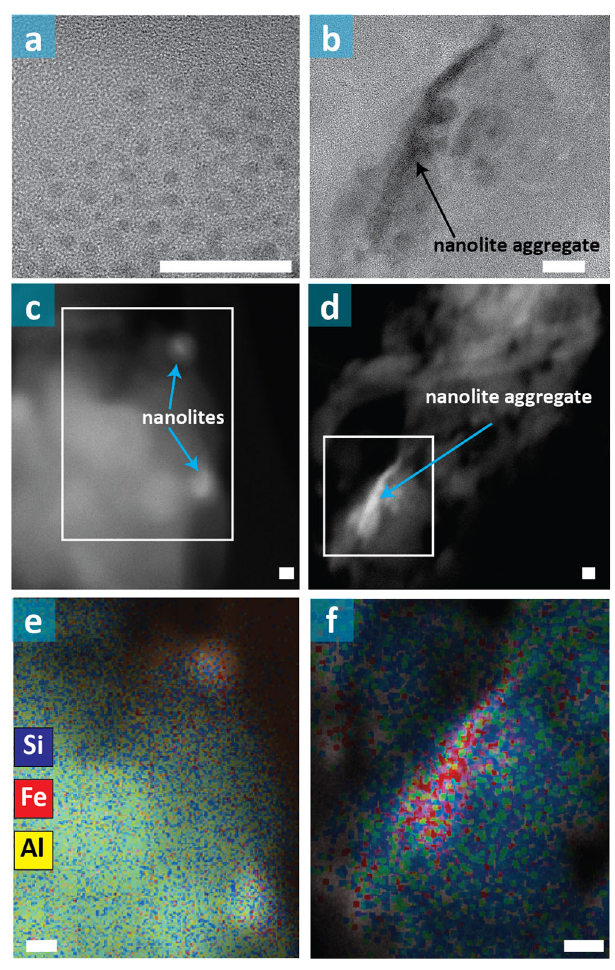
Fig. 4 Nanolite identi fi cation in the Havre 2012 pumice raft. TEM images of nanolites (darker greys) bound in the glass of the Havre 2012 for a white and b pink raft pumice. STEM micrographs of regions of c white and d pink raft pumice. EDS elemental mapping areas for e white and f pink raft pumice corresponding to the white boxes in ( c , d ). Fe-rich areas are depicted in red and represent magnetite and/or hematite nanolites. Glass areas are represented by blues, yellows to greens corresponding to high concentrations of Si and Al. Scale bars in all panels are equal to 20